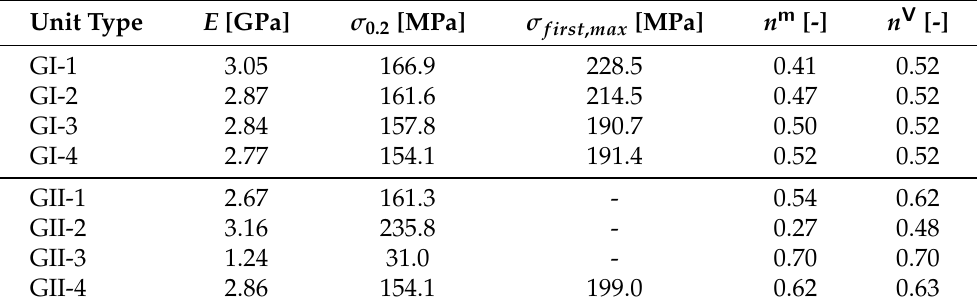
Table 5. Mechanical properties of gyroid structures from